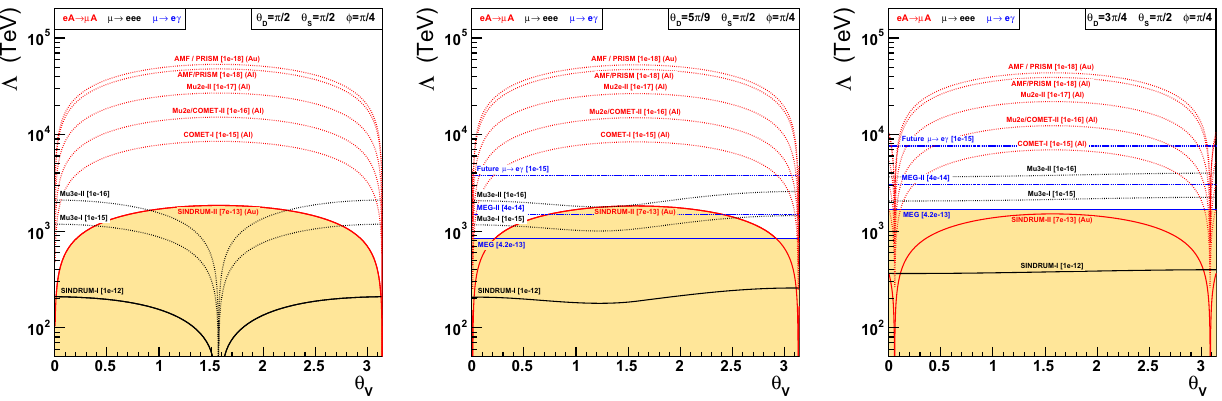
Fig. 2 Reach as a function of the angle θ V , which is effectively the angle between the μ → e ¯ ee and μ A → eA four-fermion operators, for different contributions of the dipole operator: (left) θ D = π/ 2, (middle) θ D = 5 π/ 9, and (right) θ D = 3 π/ 4. The solid region is currently excluded